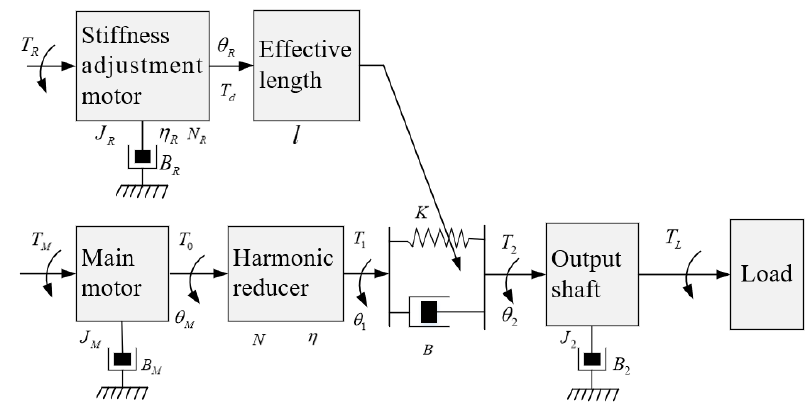
Figure 13. Dynamical Model of SCM-VSJ.